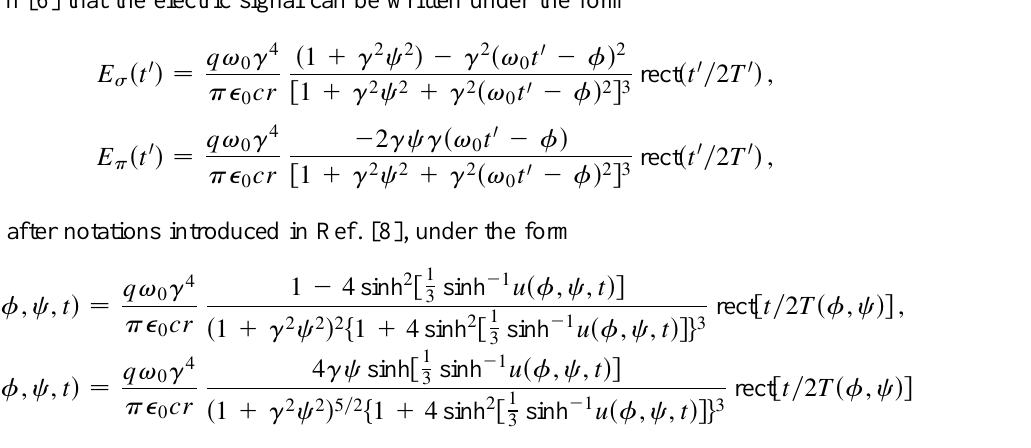
justified as to our concern since the shape of end field falloffs does not affect the energy density in the range v , v limit